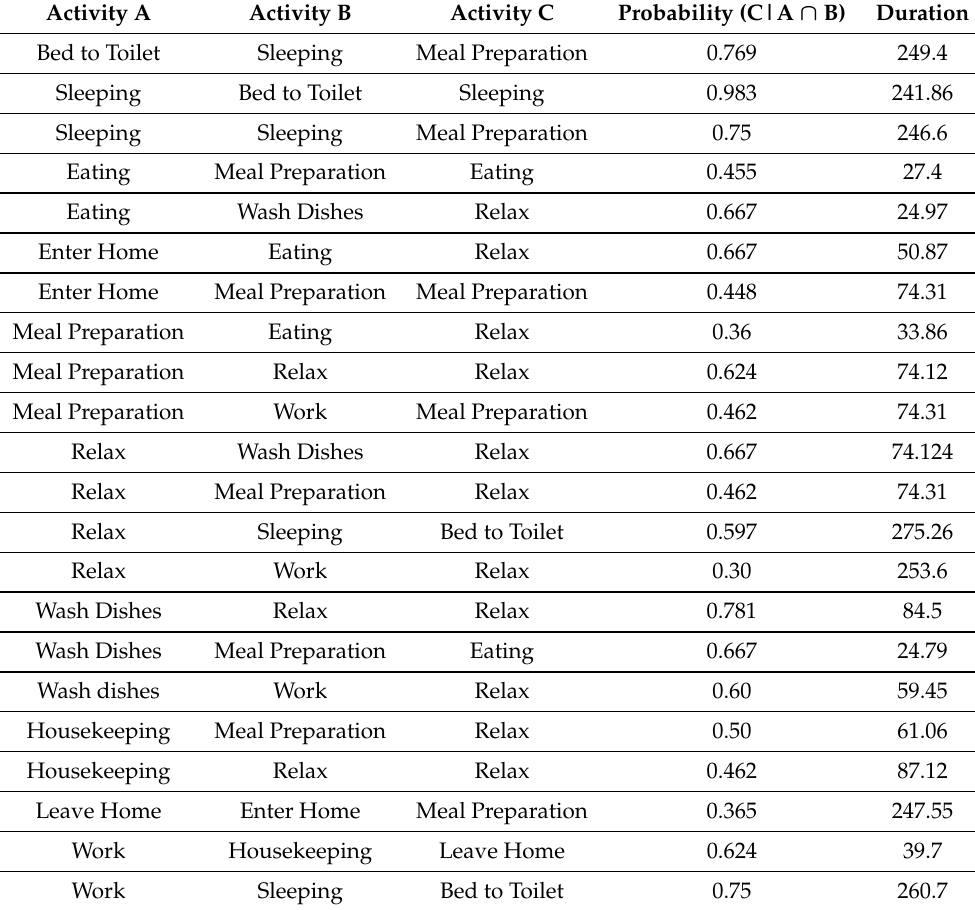
Table 7. Conditional probability for a sequence of three